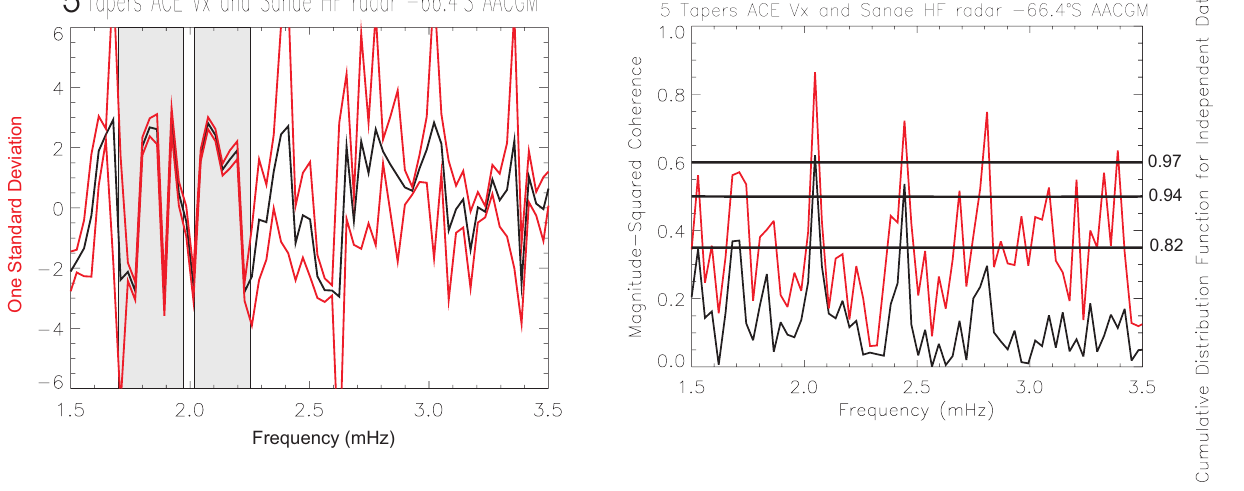
Fig. 10. ACE Vx and HF radar coherence estimates. The black curve is the MSC and the red curve is one standard deviation above it. Left hand axis shows MSC on a linearized scale. The right had side is the CDF, an estimate of the actual probability